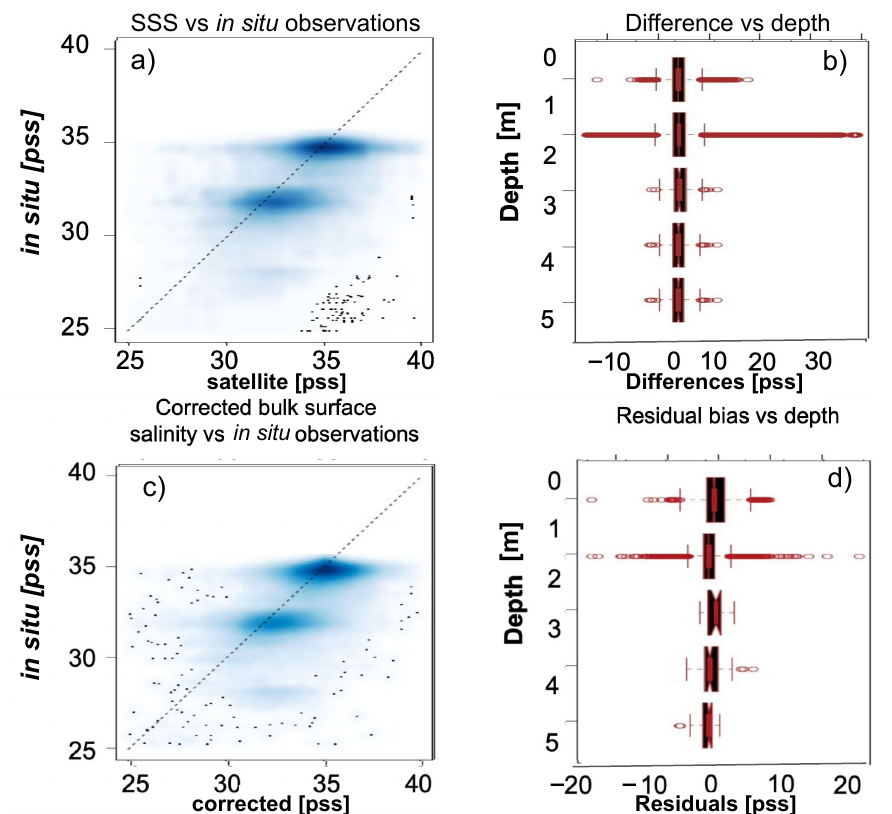
Figure 2. Comparison to in-situ salinity observations in the top-5 m (ordinate, panels a and c ): (abscissa, panel a ) SMAP-derived SSS and (abscissa, panel c ) corrected bulk surface salinity field with a Generalized Additive Model—GAM, see Equation (1)) using Level-2 SMAP-derived SSS and OAFlux data. The darker the shade of blue, the greater the number of points in the scatterplots; outliers are shown with single black dots. Additionally shown are boxplots of the SSS minus in-situ observations (panel b ) and corrected bulk surface salinity minus in-situ observations (panel d ), each as a function of binned depths in the top-5 m. The first depth bin is for 0–1 m, the second depth bin is for 1–2 m, ..., and the deepest depth bin is for 4–5